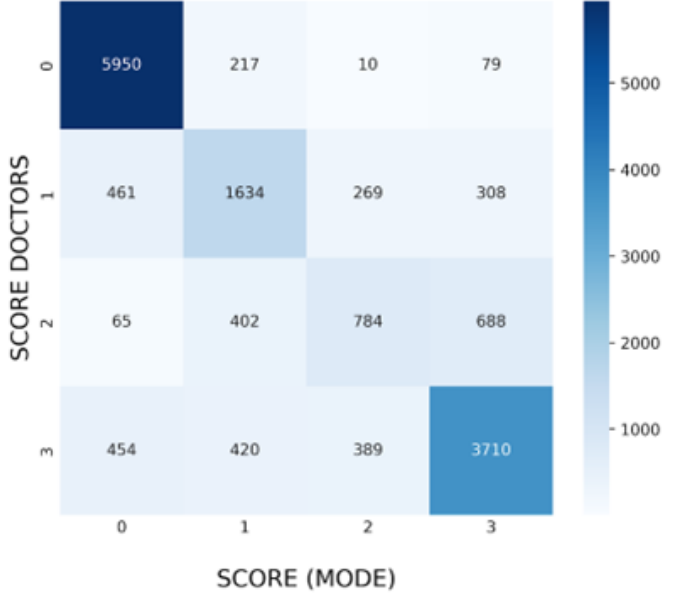
Figure 5. Scores assigned to each video (vertical axis) with respect to the most voted scores (mode, horizontal axis) among the 33 evaluations in each case.